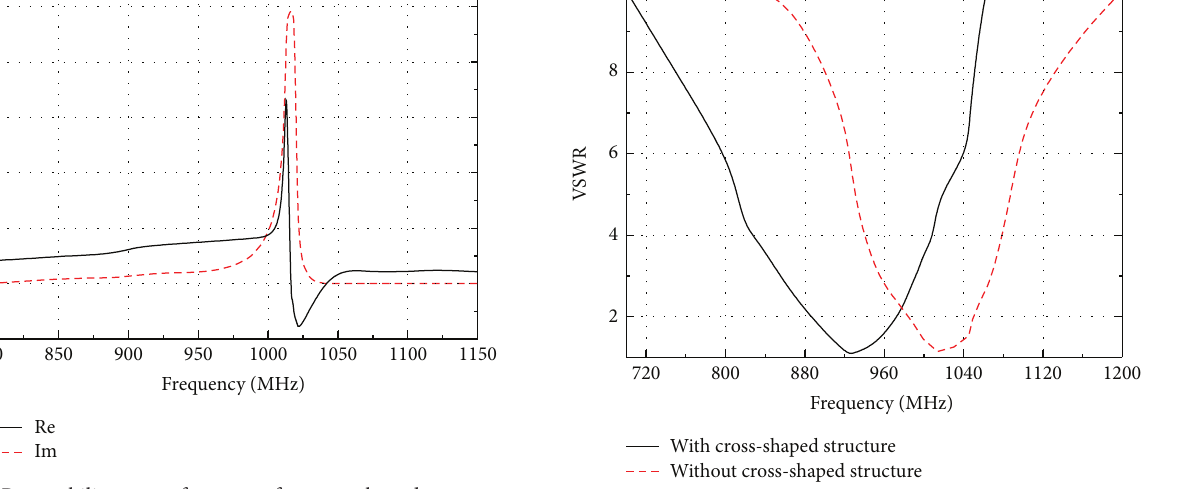
Figure 5: The VSWR of patch antenna with and without cross- shaped structure.